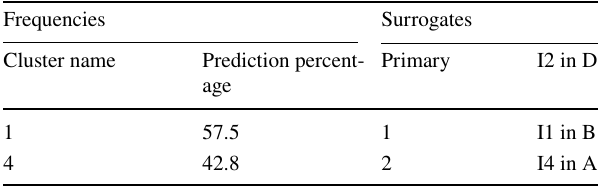
Table 13 Frequencies and surrogates data of D in